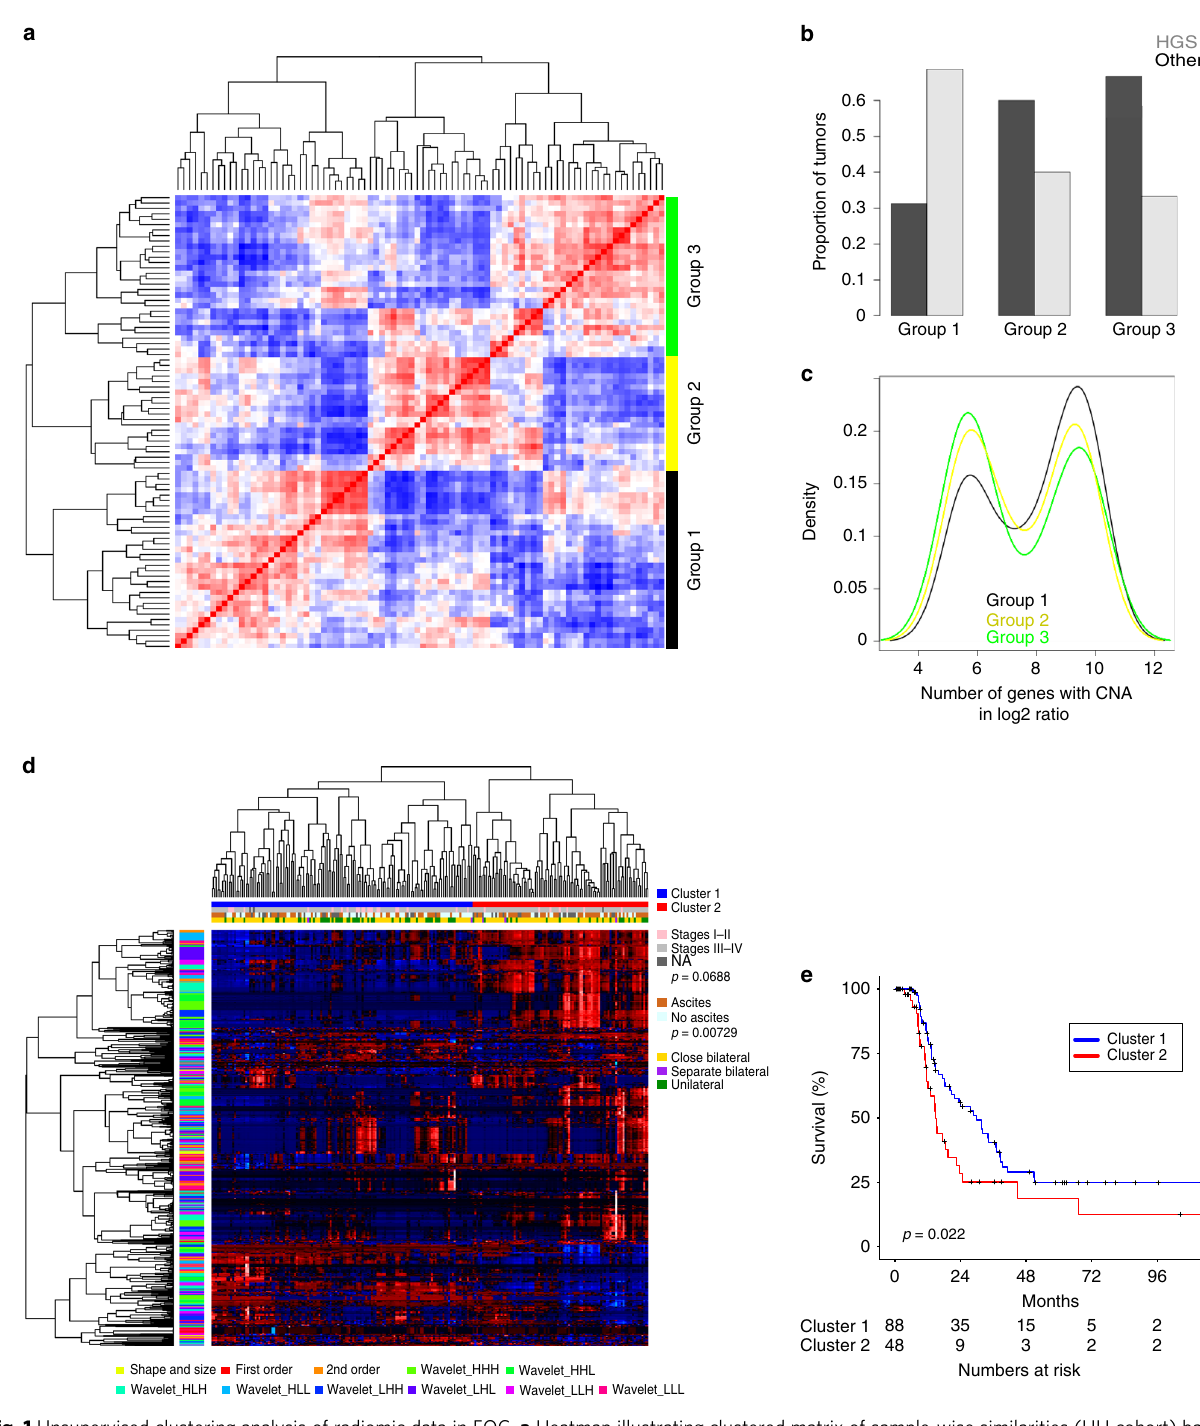
Fig. 1 Unsupervised clustering analysis of radiomic data in EOC. a Heatmap illustrating clustered matrix of sample-wise similarities (HH cohort) based on whole tumor radiomic pro fi les of primary ovarian tumors from all EOC histology. Black bar, group 1; yellow bar, group 2; green bar, group 3. b Distribution of high-grade serous ovarian carcinomas over patient groupings de fi ned by similarities of radiomic pro fi le ( n = 84, p = 0.02, Fisher ’ s exact test). c Differences in the numbers of genes affected by copy-number aberration in tumors with spectral radiomic clusters. Black line, group 1; yellow line, group 2; green line, group 3. d Unsupervised hierarchical clustering of radiomic pro fi le from primary HGSOC identi fi ed two distinct subgroups (blue and red as shown on the top row above heatmap). The associations between radiomic subgroups with the presence of ascites, lateral and tumor stage are indicated on the right. A summary of radiomic features are given on the y -axis. Blue bar, cluster 1; red bar, cluster 2. e Kaplan − Meier analysis of the radiomic subgroups with progression-free survival ( n = 136). Blue line, cluster 1; red line, cluster 2. p value from log-rank test is included. HH Hammersmith Hospital, EOC epithelial ovarian cancer, HGSOC high-grade serous ovarian